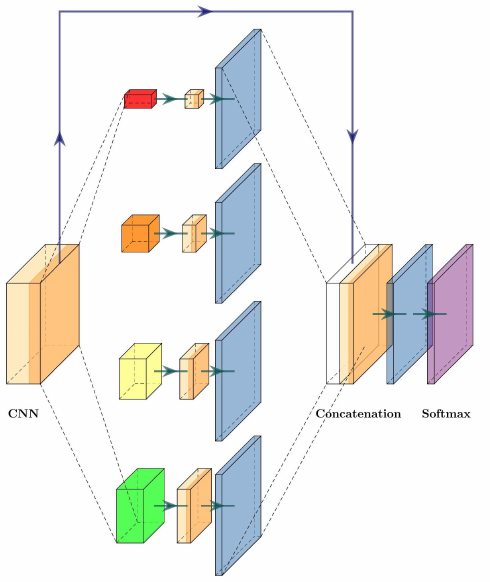
Figure 8. Pyramid pooling module.